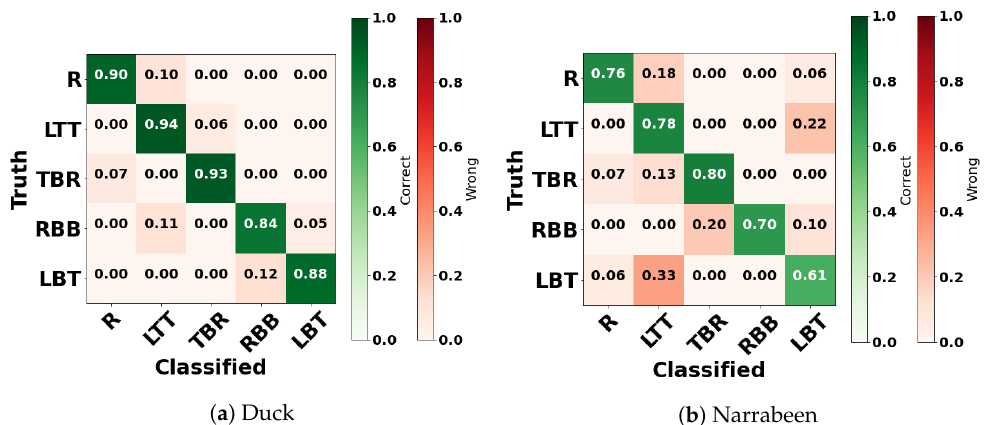
Figure 7. Normalized confusion matrices for the DUCK-CNN tests: ( a ) The per-state performance of the self-test. ( b ) The per-state performance of the transfer-test on Narrabeen. The confusion matrices show the true states on the y-axis and the state as classified by the CNN on the x-axis. Note that the confusion matrices show the recall on the diagonal in green and that the precision and F 1 score can be calculated by Equations (3) and (5),